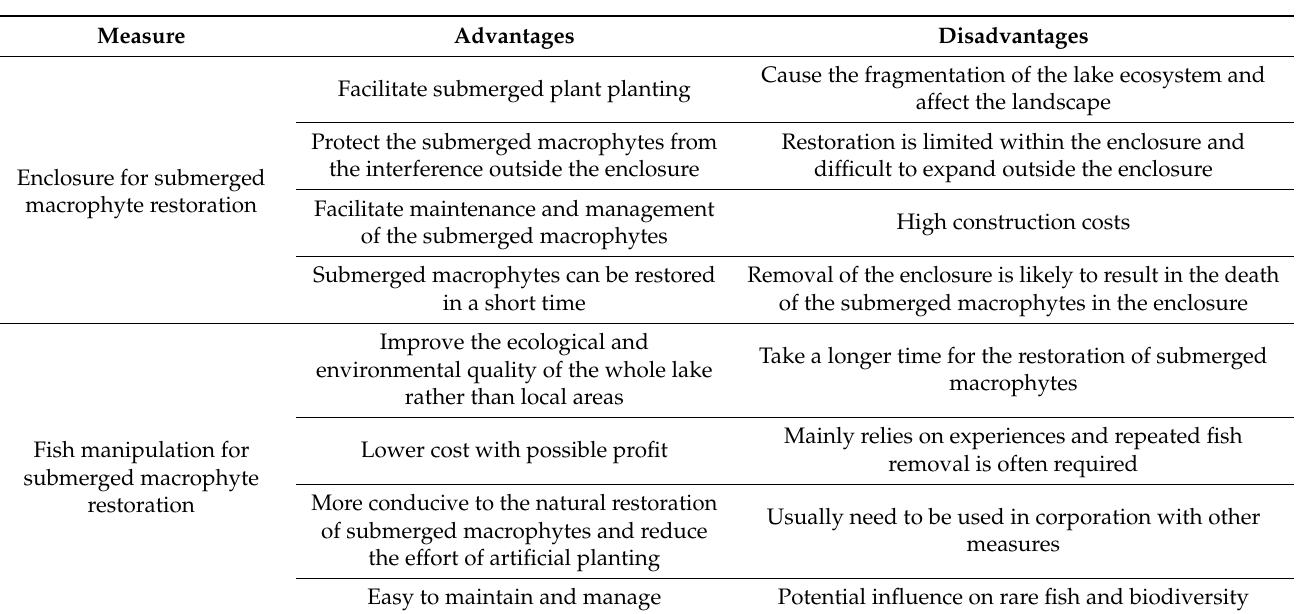
Table 1. Comparison of enclosure submerged macrophyte restoration and fish manipulation for lake